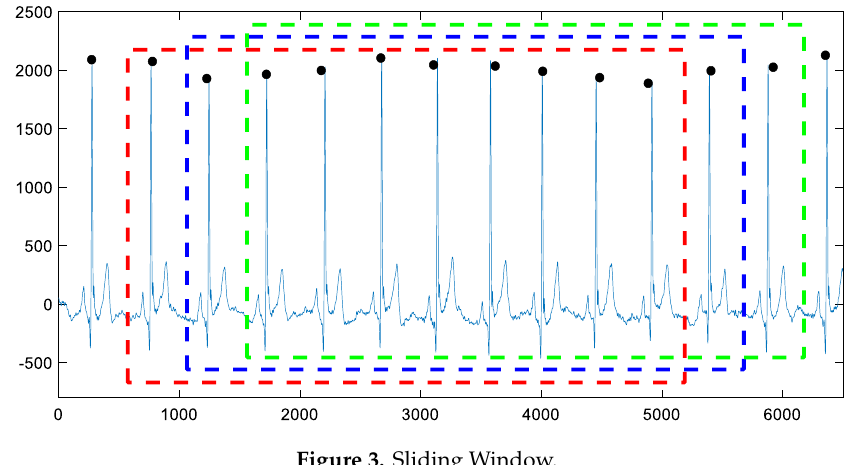
Figure 3. Sliding Window.